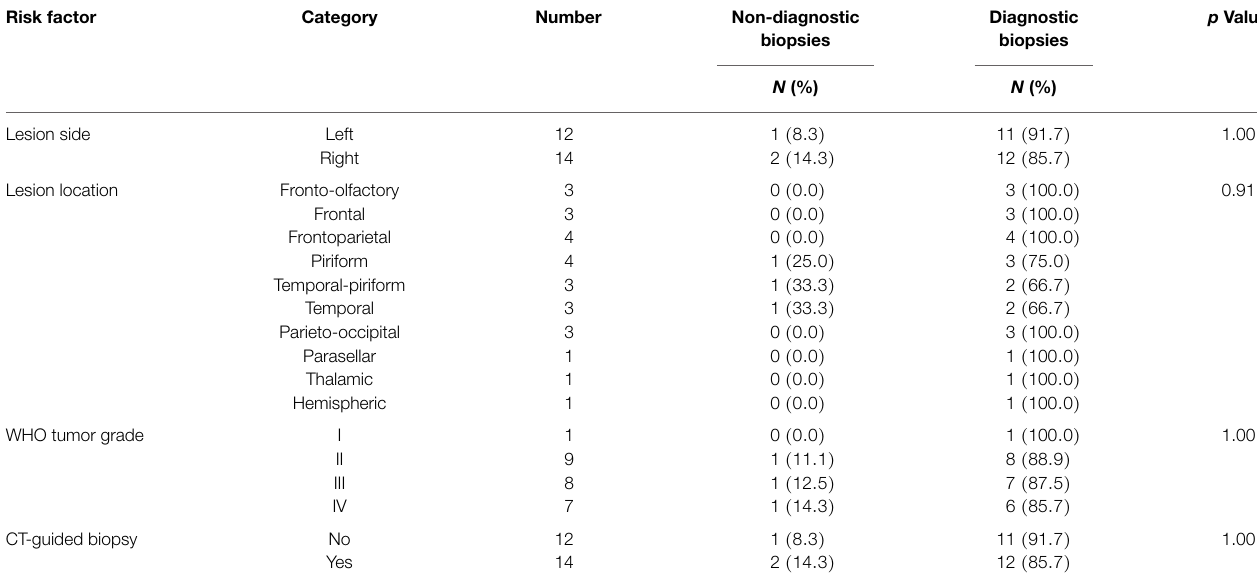
TABLE 4 | Analysis of categorical risk factors associated with obtaining a non-diagnostic stereotactic brain biopsy . Risk factor Category